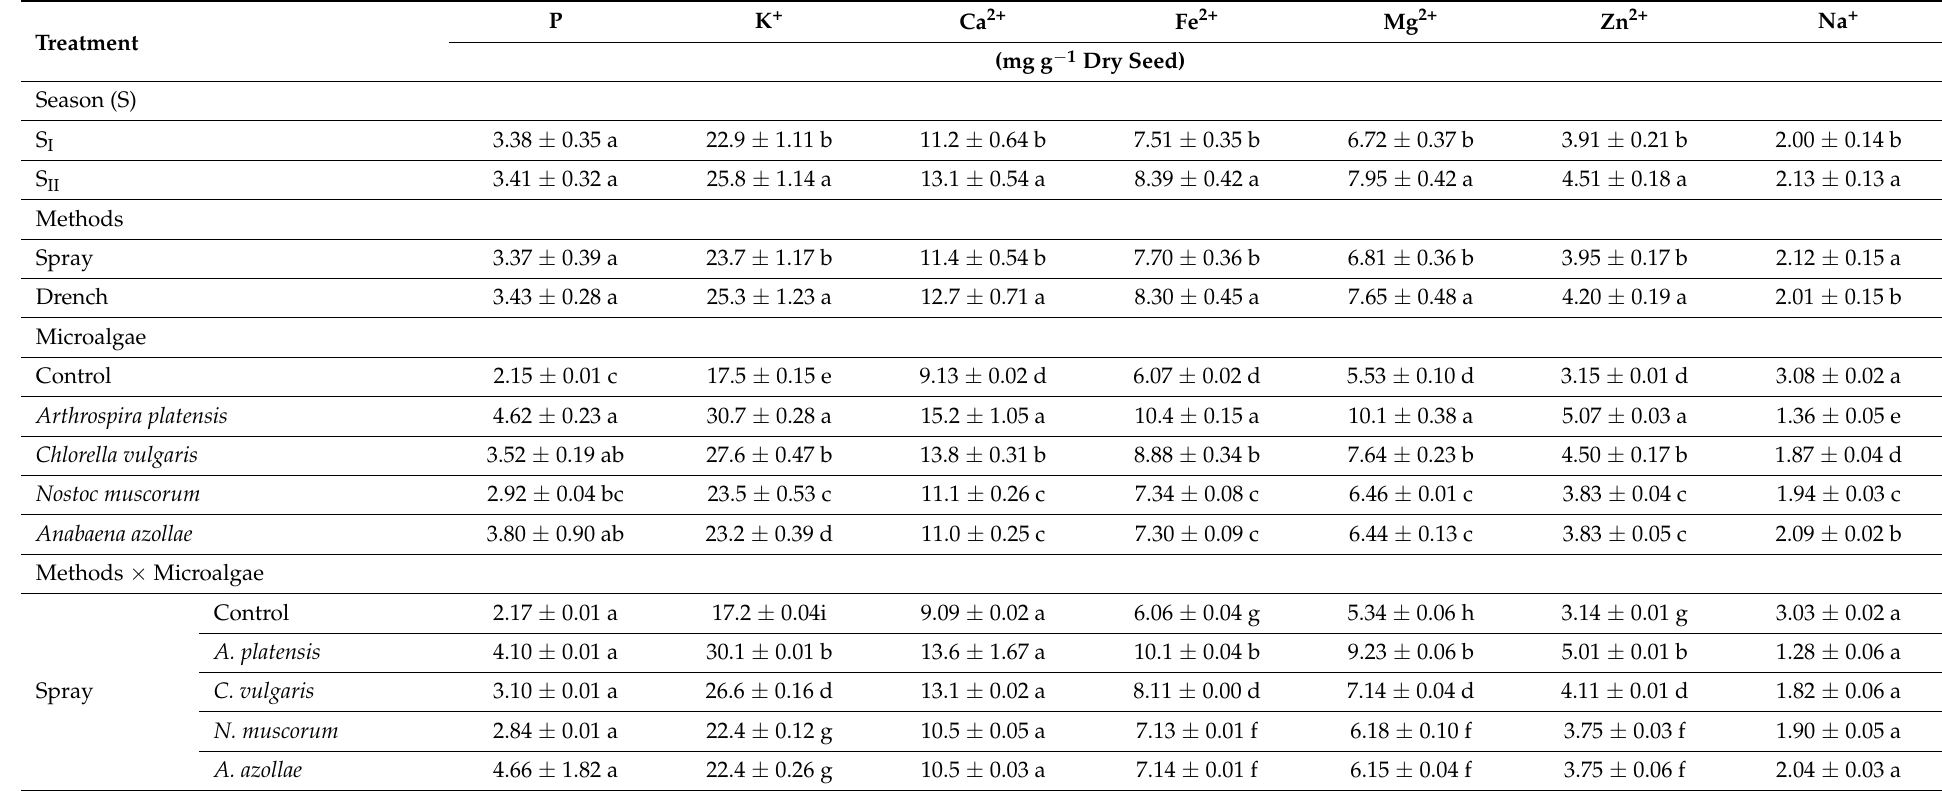
Table 6. Mineral content (P, K, Ca 2+ , Fe 2+ , Mg 2+ , Zn 2+ , and Na 2+ ) of chia seeds cultivated under alkaline stress conditions in response to different application methods, microalgae strains, and their